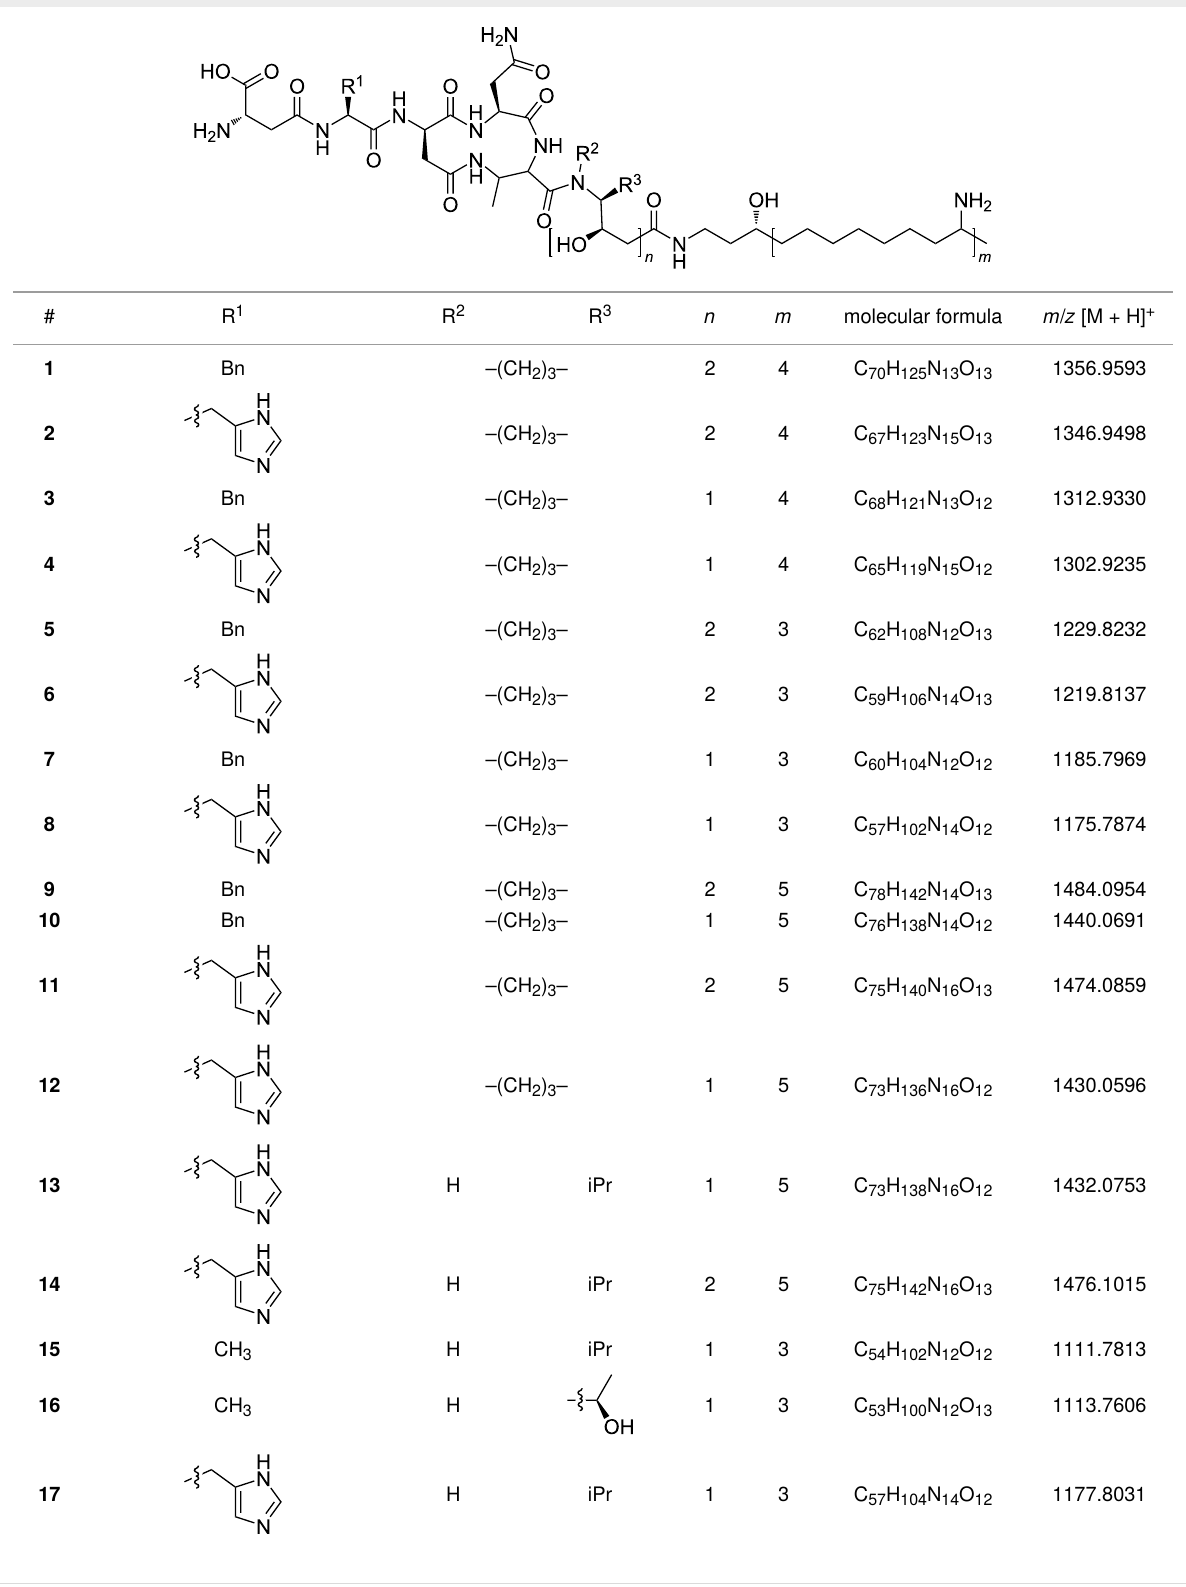
Table 1: Compound list of the fabclavine derivatives identified in this work. The structures are based on MALDI–HRMS and MALDI–MS 2 analyses using the known structure of 1 as a reference [20]. The derivatives 1 – 4 and 17 – 22 were described previously